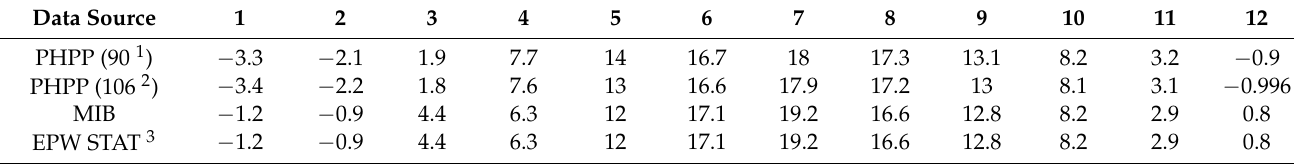
Table 3. Summary of average temperatures for respective months [ ◦ C]. Own study based on data from the ISO file from the Ministry of Infrastructure, the EPW file and data from PHPP v